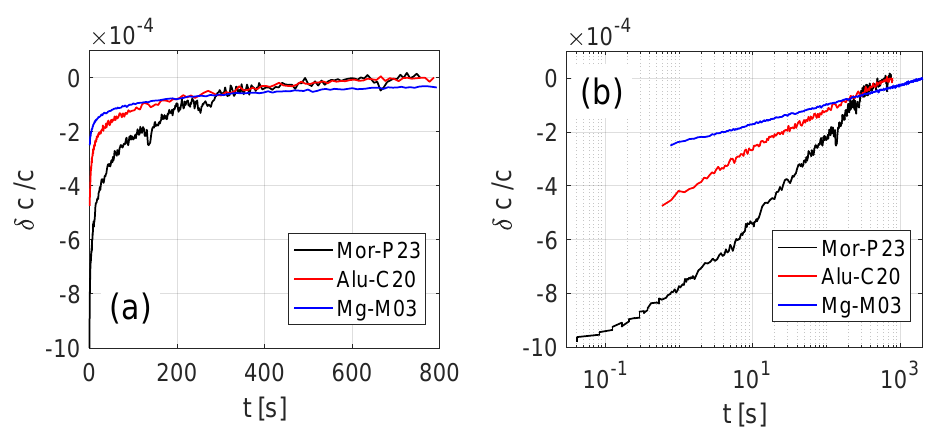
Figure 1. Experimental result for relaxation. ( a ) Linear scale; ( b ) Semi-logarithmic scale. Results for mortar and Al and Mg based alloys are shown to allow comparison. Data from mortar have been acquired using a protocol different than that presented here, which allows to monitor earlier times of relaxation, but, being more noisy, it could not be used to analyse relaxation in metals. For metals we obtain very small variations in the wave velocity (of the order of a few per thousands), which are comparable to resonance frequency variations δ f / f induced by slow dynamics in metals observed by Johnson and Sutin [33]. Note that for longitudinal vibrations δ c / c = δ f / f , since the resonance frequency is proportional to the wave